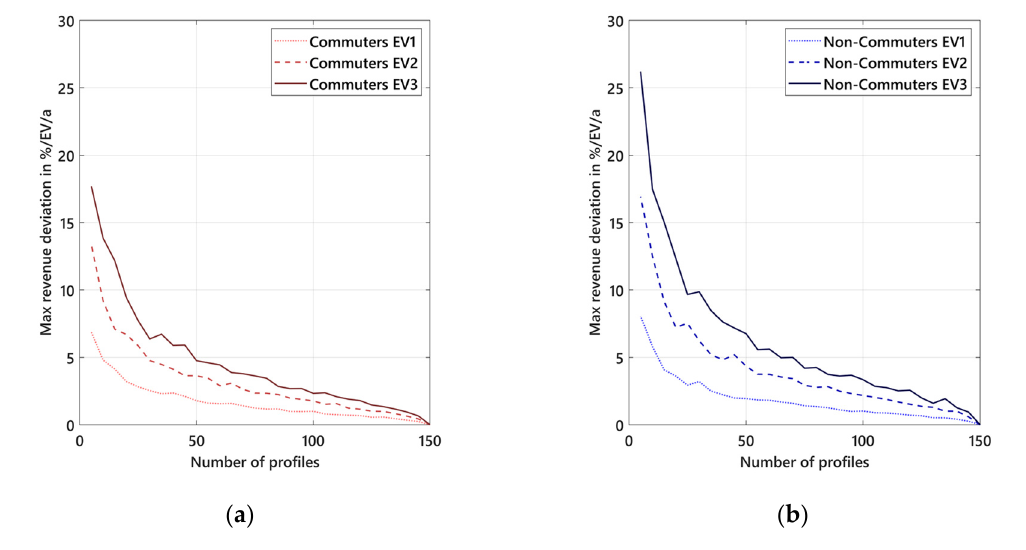
Figure A2. Maximum revenue deviation for a varying number of profiles compared to the best case of 150 profiles for a drawing of 50,000 EV profile groups for commuters ( a ) and non-commuters ( b ). The more vehicles that are modeled, the less is the maximum revenue deviation. A relevant pool size for the EV pool scenarios can be determined by the revenue di ff erence falling below a defined threshold value. A maximum deviation of less than 5% per vehicle per year is assumed to be su ffi ciently accurate while limiting computational time. This results in a relevant pool size of 50 vehicles for a commuter EV pool. A representative non-commuter EV pool needs a number of 75 vehicles. Revenues of non-commuters are more heterogenic than revenues of commuters because commuters have a more regular driving profile during